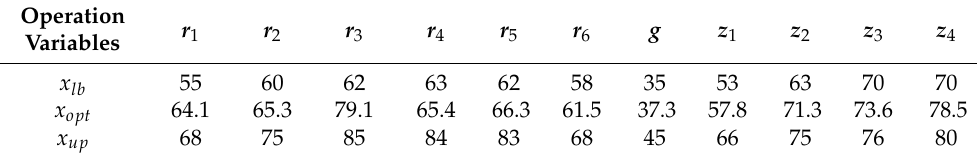
Table 1. The optimal values and boundary values of decision variables.